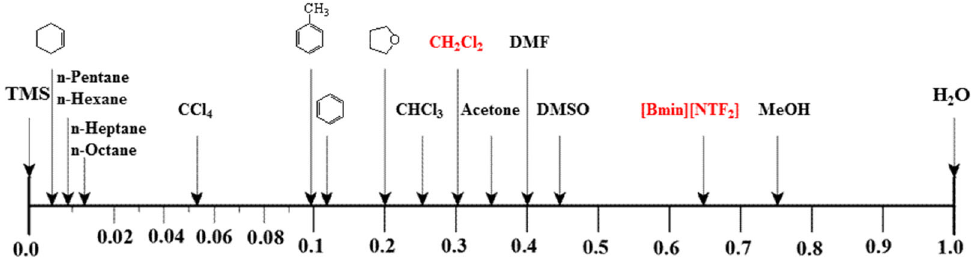
Figure 4. Normalized solvent polarity scale E N T with E N T = 0.00 for tetramethylsilane (TMS) and E N T = 1.00 for water as arbitrarily fixed points, with an ordering of eighteen molecular solvents and [Bmim][NTf 2 ] on this scale.